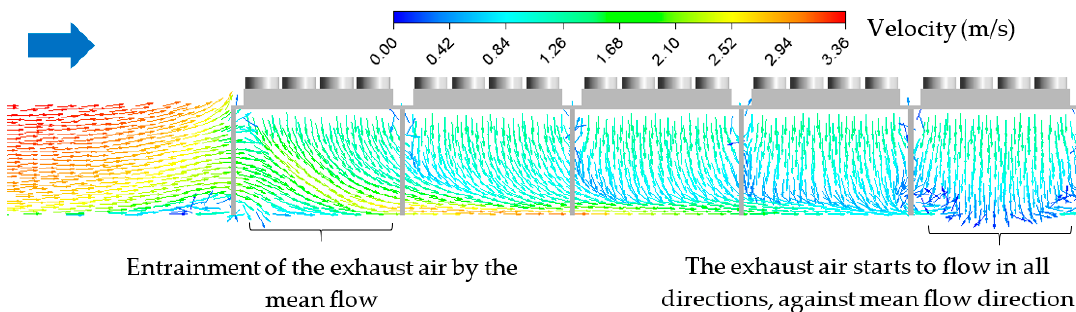
Figure 9. Velocity streamlines below the evaporators, uniform field and south wind condition.